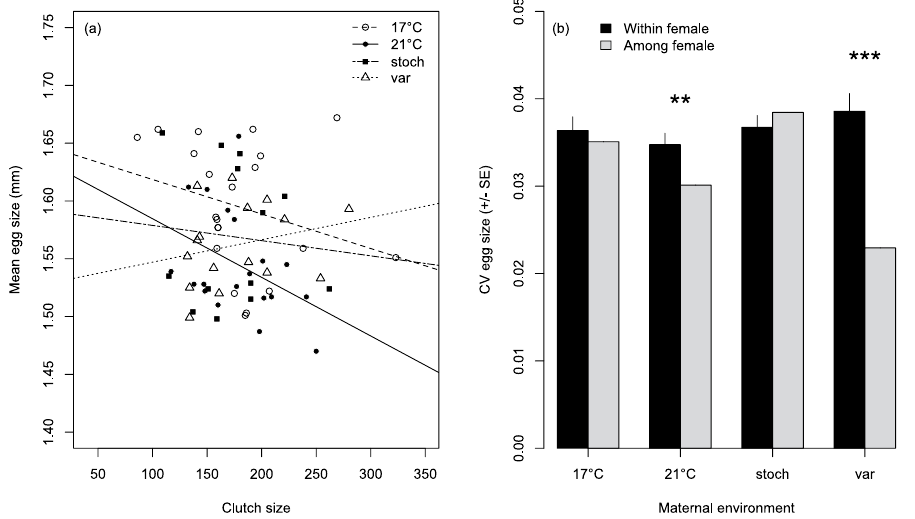
Figure 1. Mean egg size, clutch size, and egg size variability of female stickleback ( Gasterosteus aculeatus ) acclimated to the four experimental temperature treatments (constant 17 °C, constant 21 °C, predictably variable, and stochastically variable). ( a ) Relationship between clutch size (total number of eggs per female) and mean egg size (diameter ± 0.01 mm of 40 eggs per female) in the four treatments (Note: lines connect clutches within each maternal environment), and ( b ) egg size variability estimated by the coefficient of variation (CV) of egg size depicted as within-female variability (black bars) and among-female variability (grey bars), ** P < 0.01, *** P < 0.001.